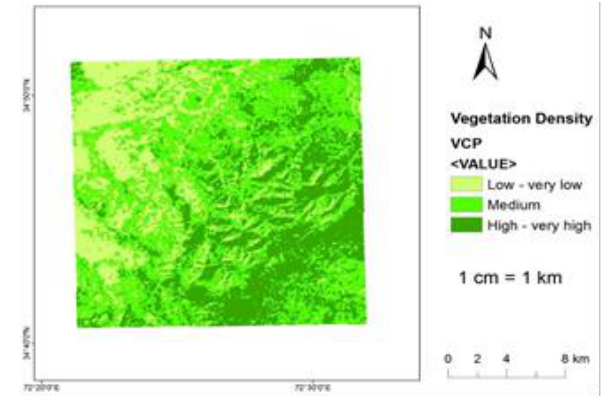
Figure 5: Distribution of vegetation cover based on VCP in the 2000s